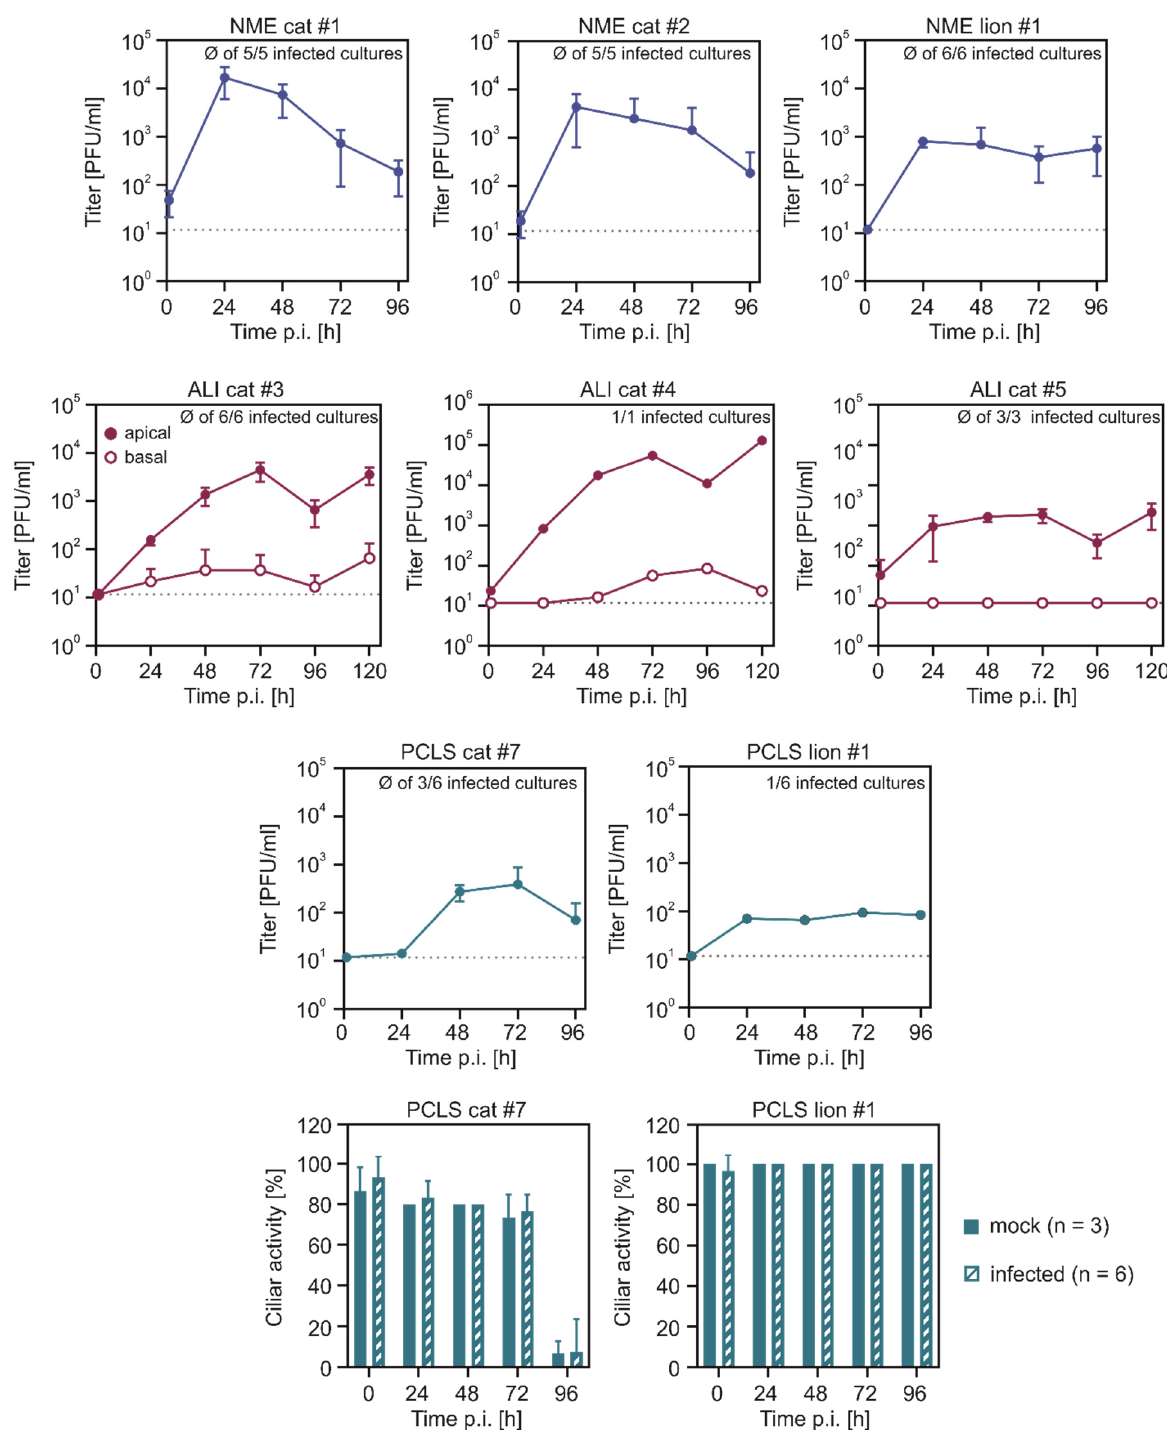
Figure 1. Viral replication of SARS-CoV-2 in feline primary respiratory cell cultures. Nasal mucosa explants (NMEs), air-liquid interface (ALI) cultures derived from the trachea, and precision-cut lung slices (PCLSs) were infected with SARS-CoV-2. Supernatants were collected at the indicated time points and viral titres were determined by titration on Vero E6 cells. Viral titres are given as PFU/mL. Ciliary activity of infected and uninfected PCLSs was semi-quantitatively determined by light microscopy. The graphs show the means and SD of n replicates as indicated in each graph. For viral replication in PCLSs, only slices for which viral replication above the limit of detection has been measured were included in the graph. The dashed lines indicate the limit of detection.